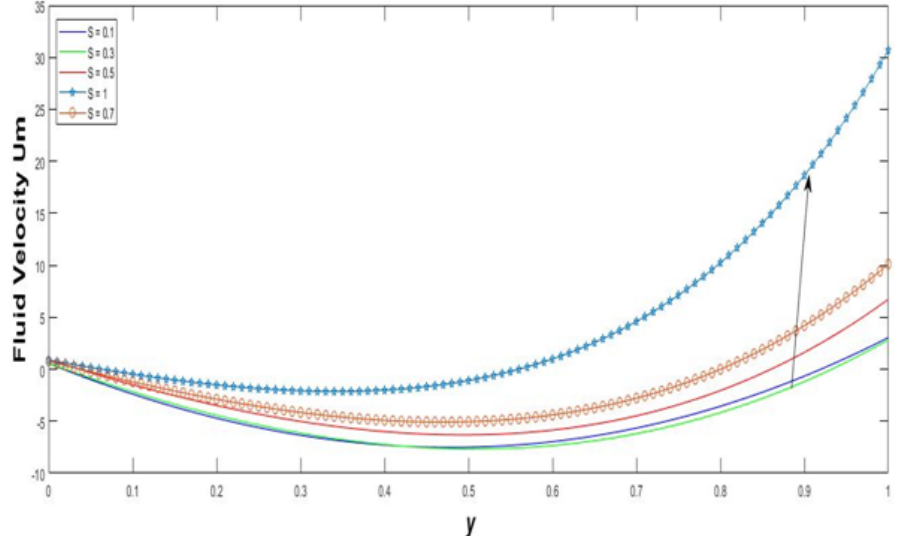
Figure 2. Velocity field for various injection parameters.